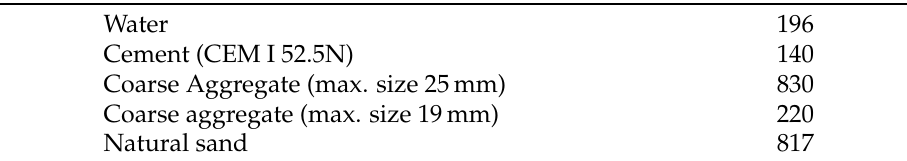
Figure 1. ( a ) Extraction of authentic specimens and ( b ) authentic specimens with large aggre- gates/stones. Table 1. PCLAB mixture ∗ (laboratory reproduced LPC) in kg/m 3 , Reprinted with permission from [7], Copyright 2021 Elsevier.